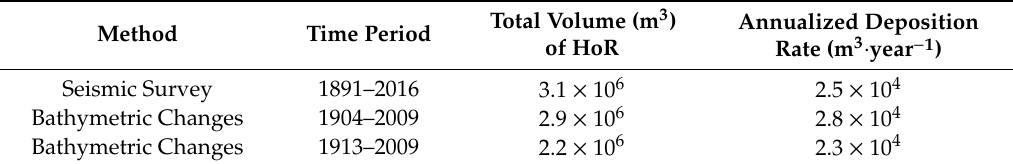
Figure 9. Grainsize measured for cores HoR-1, HoR-1B, HoR-3, HoR-3B and HoR-5. Full textural data is available in the supplemental materials. Table 1. Total sediment volume and annualized deposition rate (over 125 years) for the seismic profiles and bathymetric